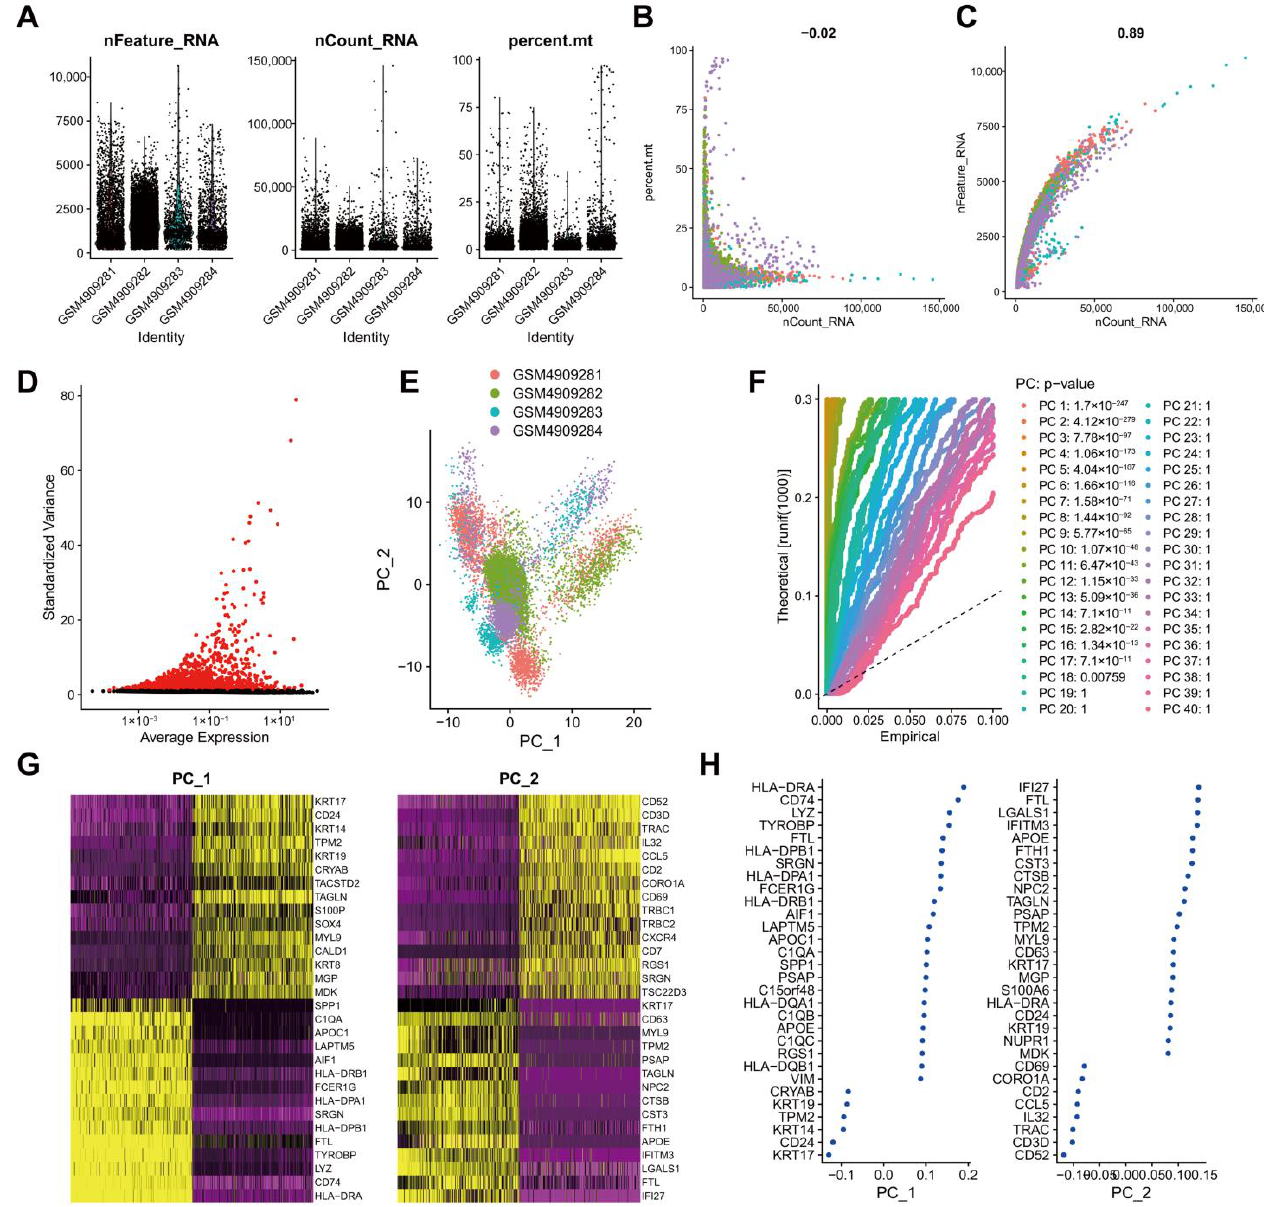
Figure 2. Analysis of the scRNA-seq data from human TNBC tissue samples. ( A ): Expression of scRNA-seq data. Each dot represents one cell, nFeature_RNA ordinate represents the number of genes expressed in each cell, nCount_RNA ordinate represents the number of UMI in each cell, and percent.mt ordinate indicates the proportion of the UMI of the mitochondrial genes per cell to the total UMI of each cell; ( B ): A scatter plot of the relationship between the UMI and the total number of genes; ( C ): Highly variable genes in tumor tissue samples following variance analysis. Red dots represent highly variable genes, and black dots represent invariable genes; ( D ): PCA of cell cluster; ( E ): p values of each principal component compared using the JackStrawPlot function. Above the dotted line indicates a p value less than 0.05; ( F ): Principal components used for the subsequent analysis determined by the ElbowPlot function (the turning point was determined according to the variance change); ( G ): A dot plot of the related genes in the top two principal components. The larger absolute value of the abscissa value reflects the higher correlation; ( H ): A heat map of the expression of related genes in the top two principal components. The darker color reflects the greater expression.